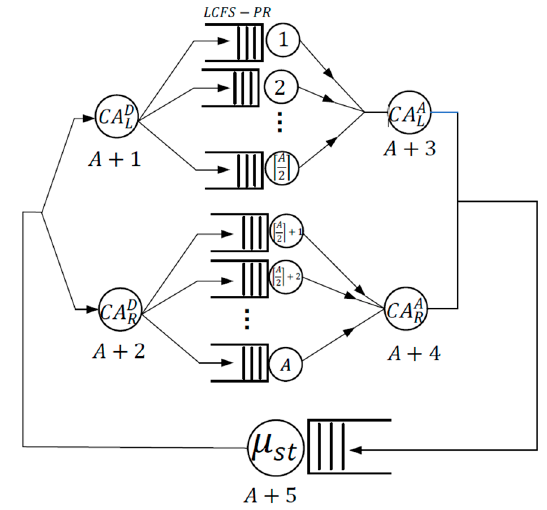
Figure 4. Queuing network model CQN2.